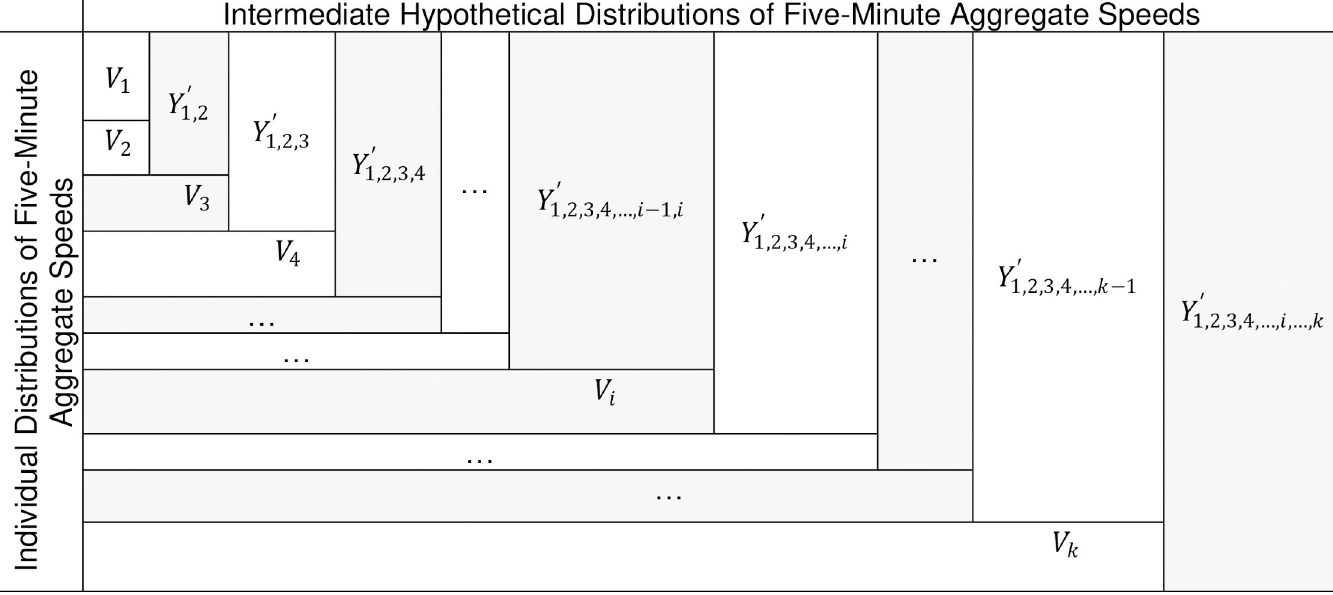
PLOS ONE | https://doi.org/10.1371/journal.pone.0256322 August 16,